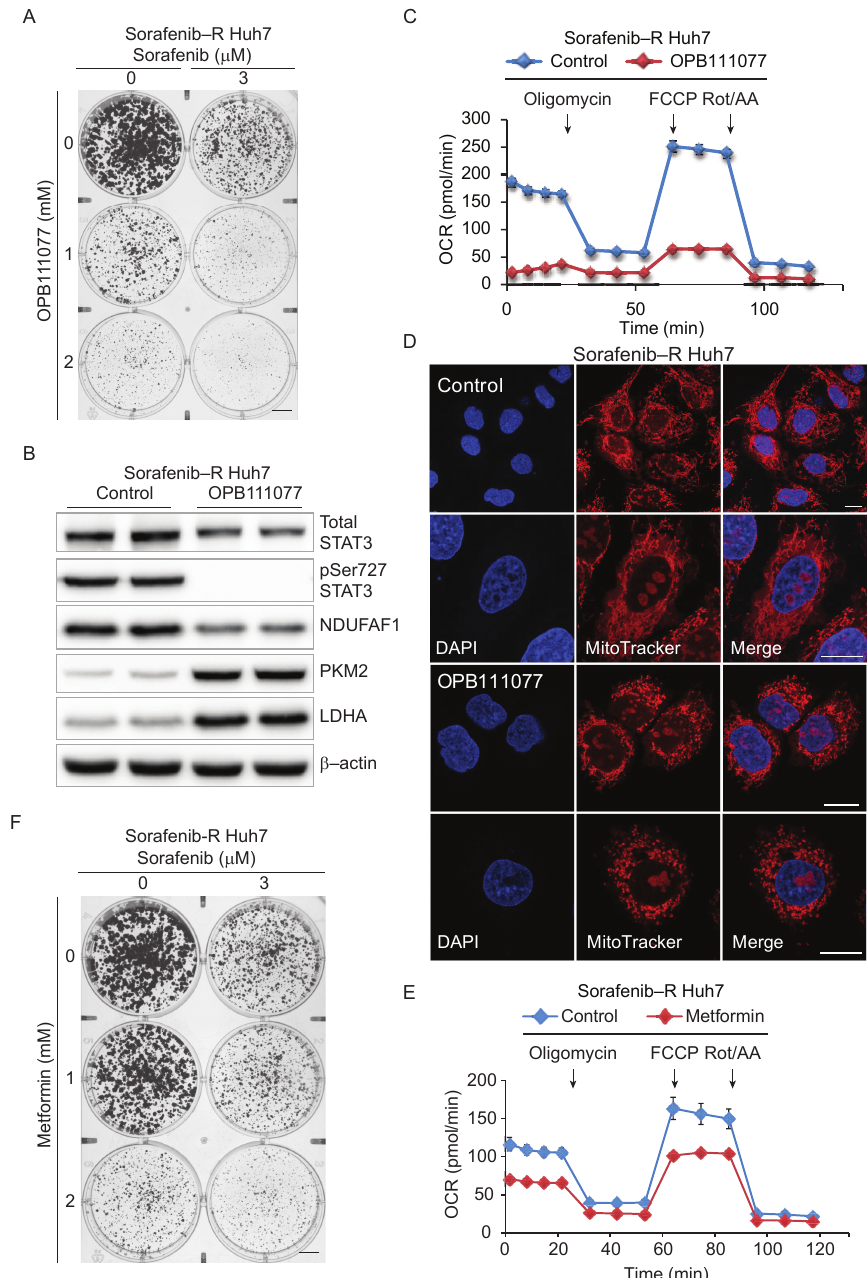
Figure 5. STAT3 inhibition restores mitochondria function and sensitivity to sorafenib. ( A ) Clonal growth of sorafenib-resistant cells treated with sorafenib and increasing concentrations of OPB-111077. ( B ) Expression of total and pSer 727 STAT3, NDUFAF1, PKM2, and LDHA in sorafenib-resistant cells untreated (Control) and treated with OPB-111077 (10 µ M, 72 h). ( C ) Mitochondrial OCR in sorafenib-resistant Huh7 cells untreated (Control) and treated with OPB111077 (10 µ M, 5 h). Basal respiratory capacity, p ≤ 0.005. ( D ) Confocal microscopy images of sorafenib-resistant Huh7 cells untreated ( top panels) and treated ( bottom panels) with OPB-111077 (10 µ M, 16 h) and stained with Mitotracker Orange and DAPI. Representative images at 10 × and 20 × magnification. Bars: 10 µ m. ( E ) Mitochondrial OCR in sorafenib-resistant Huh7 cells untreated (Control) and treated with met- formin (3.5 mM, 5 h). Basal respiratory capacity, p ≤ 0.005. ( F ) Clonal growth of sorafenib-resistant cells treated with sorafenib and increasing concentrations of